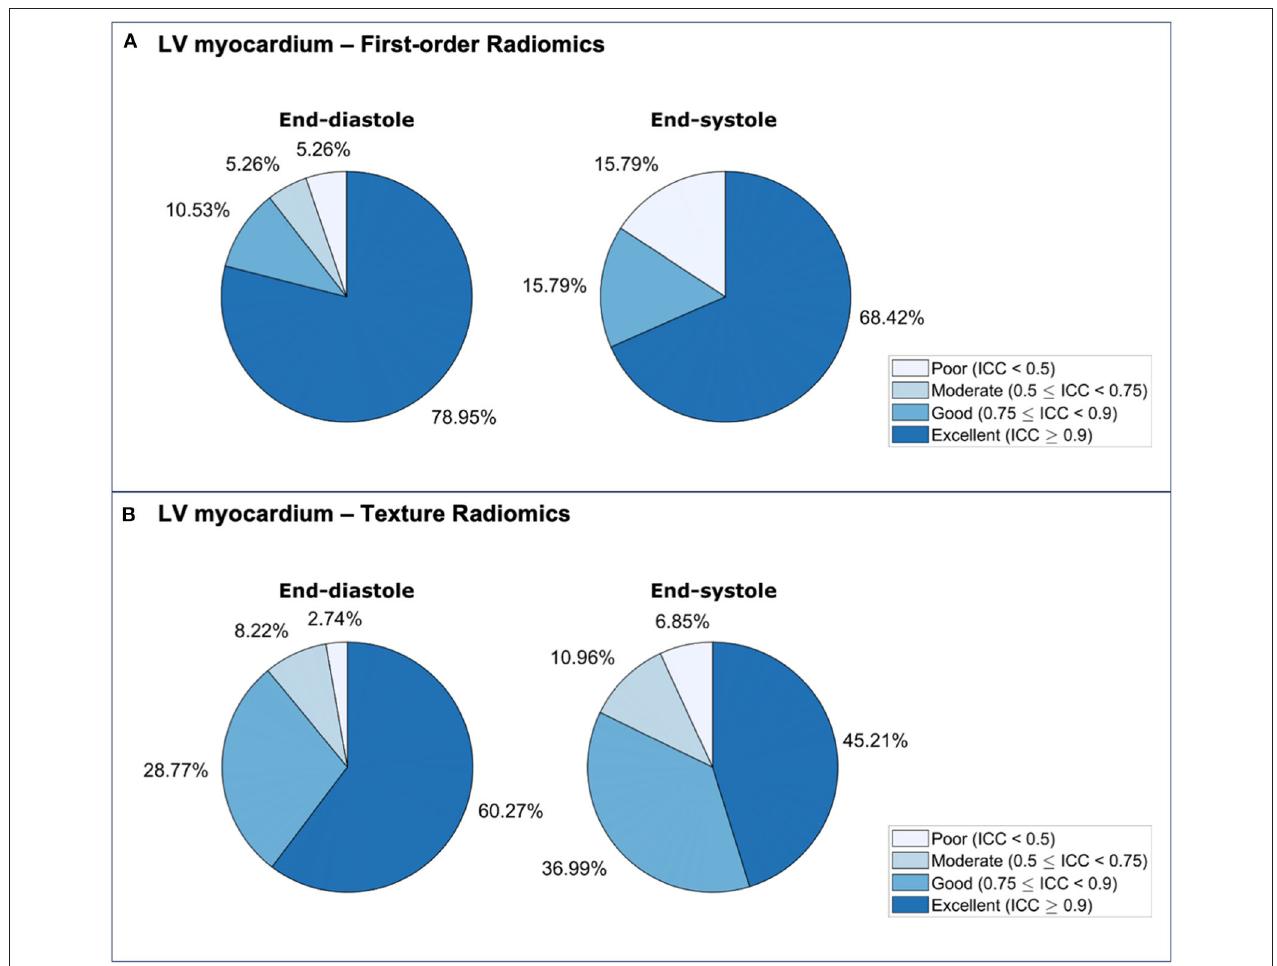
FIGURE 7 | Repeatability of LV myocardium radiomics first-order (A) and texture (B) features in end-diastole and end-systole. ICC: intra-class correlation coefficient; LV: left ventricle.